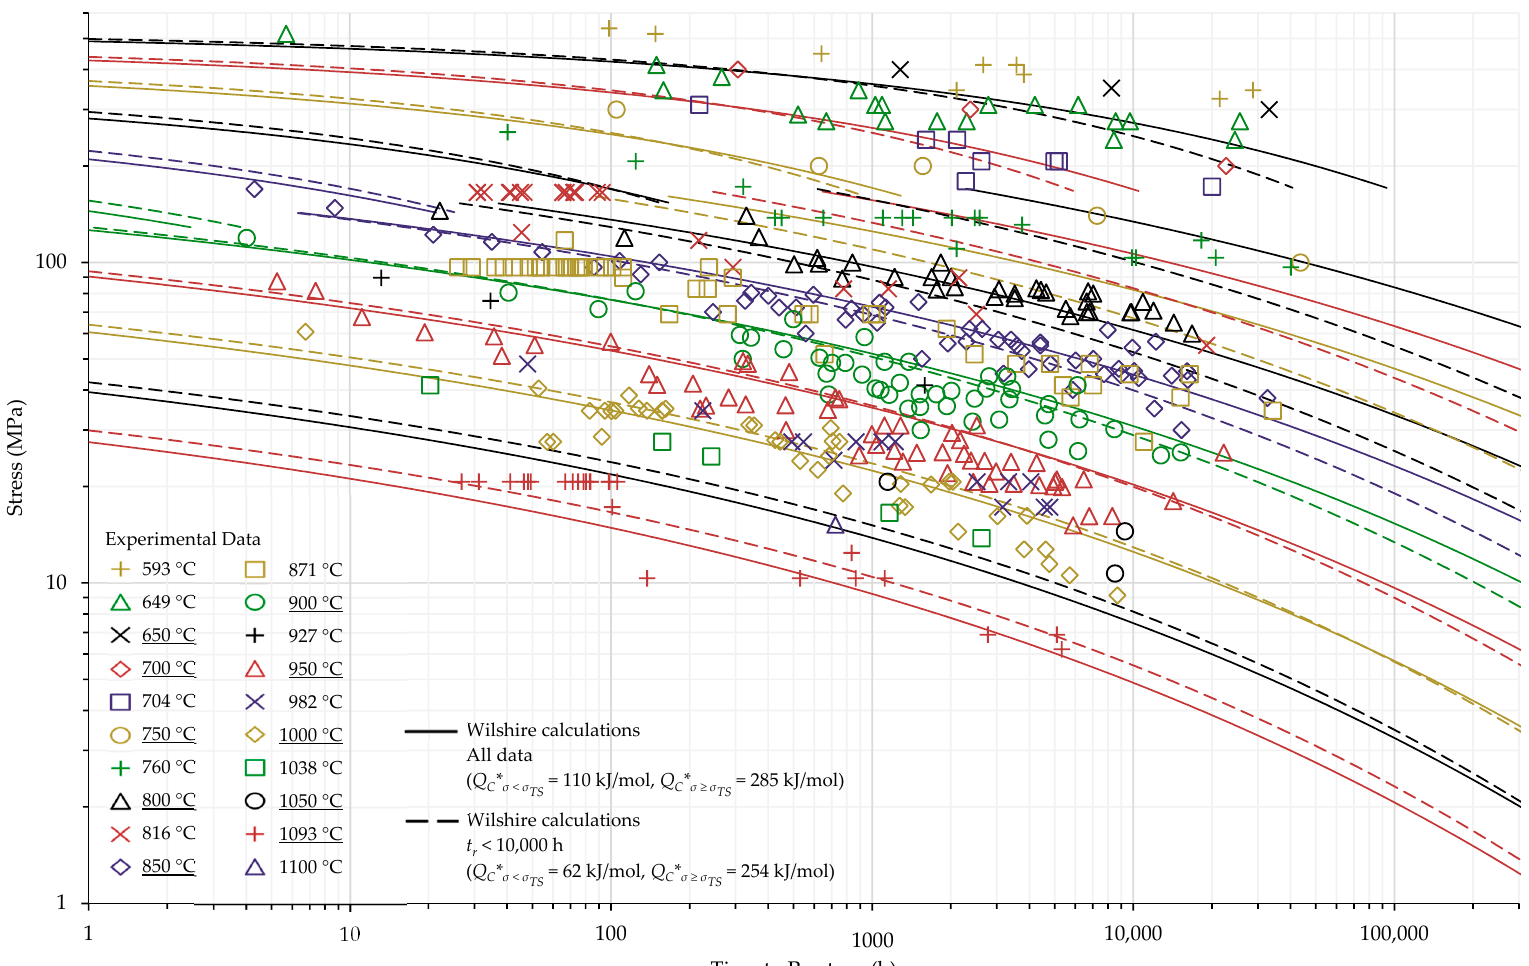
Figure A10. Split region calculations of the Wilshire equation with Q ∗ determined using Arrhenius plots for Inconel 617 shown at underlined temperatures.